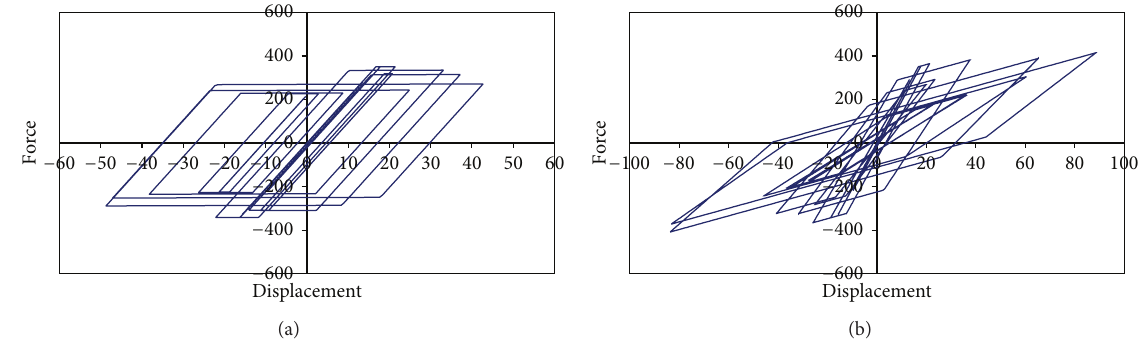
Figure 2: Hysteretic model with degradation in (a) strength and (b) strength and stiffness.